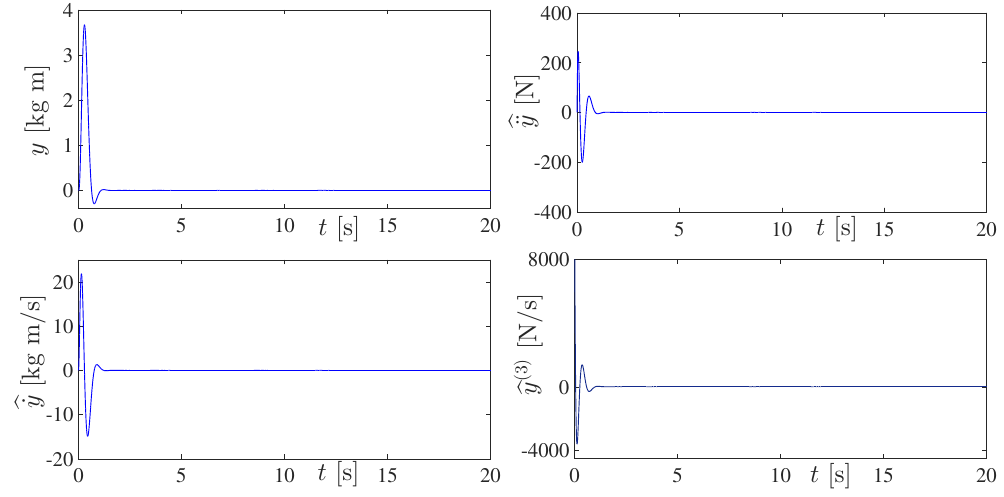
Figure 11. Flat output and its time derivatives used for active disturbance suppression control.